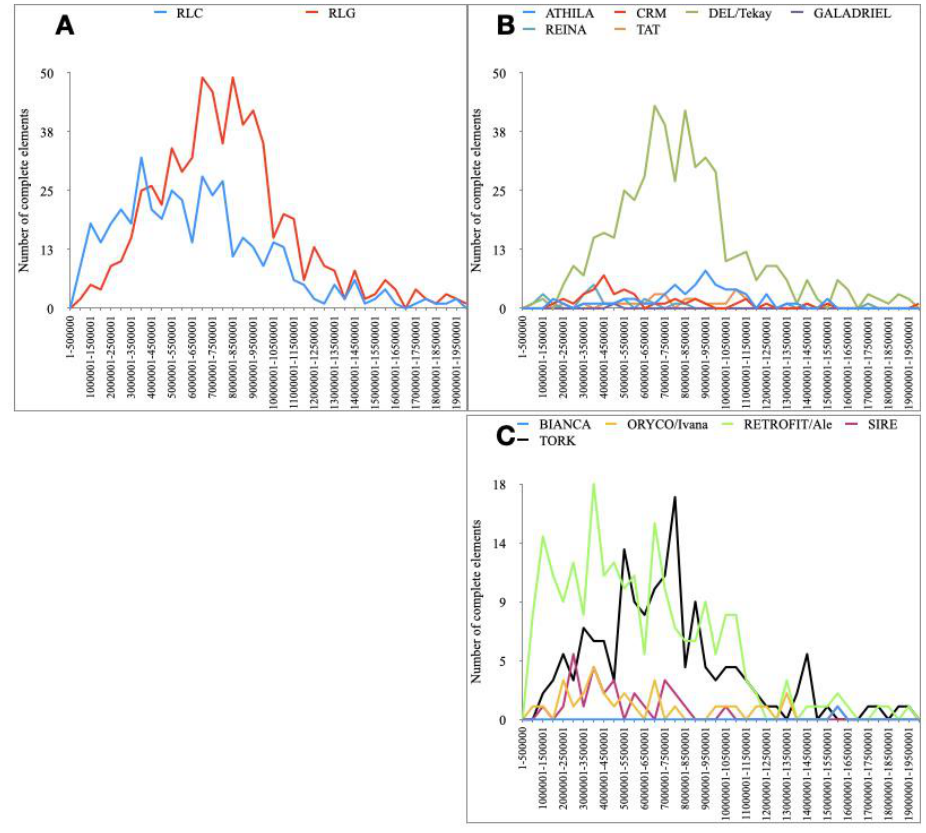
Figure 4. Timing of full-length LTR retrotransposon insertions into the H. brasiliensis clone PB 260 genomic sequence. ( A ) Blue and red lines represent, respectively, the number of Ty1/copia (RLC) and Ty3/gypsy (RLG) full-length LTR retrotransposons per bins of 0.5 Million Years (MY). ( B ) Coloured lines represent the number of full-length Ty3/gypsy (RLG) LTR retrotransposon lineages per bins of 0.5 MY. ( C ) Coloured lines represent the number of full-length Ty1/copia (RLC) LTR retrotransposon lineages per bins of 0.5 MY. Only the full-length LTR retrotransposons found by LTR_STRUC were used here. An average substitution rate of 3.89 × 10 −9 was used.